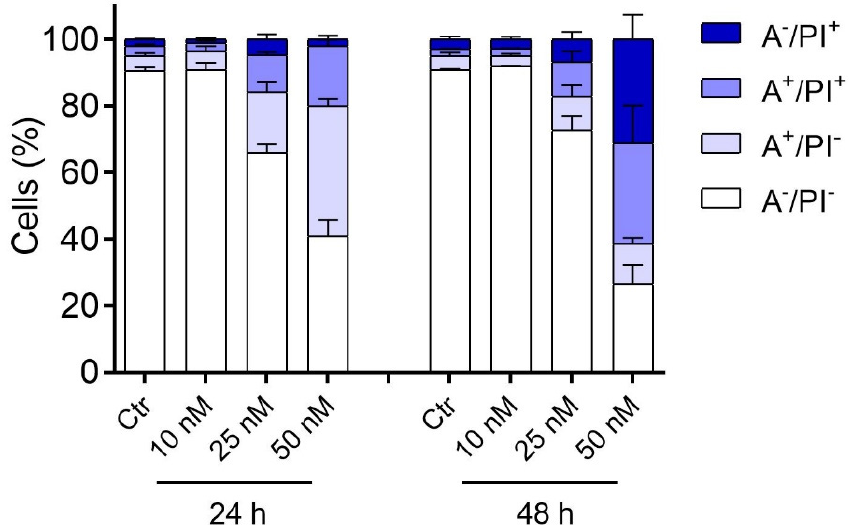
Figure 5. Apoptotic effects caused by 3d . HeLa cells were treated with the indicated concentrations of 3d for either 24 or 48 h and then were analyzed by flow cytometry after double staining with annexin-V-FITC and PI. A − /PI − Alive cells; A + /PI − Early apoptotic cells; A + /PI + Late apoptotic cells; A − /PI + Necrotic cells. In the histograms, data are represented as mean ± SEM of three independent experiments.